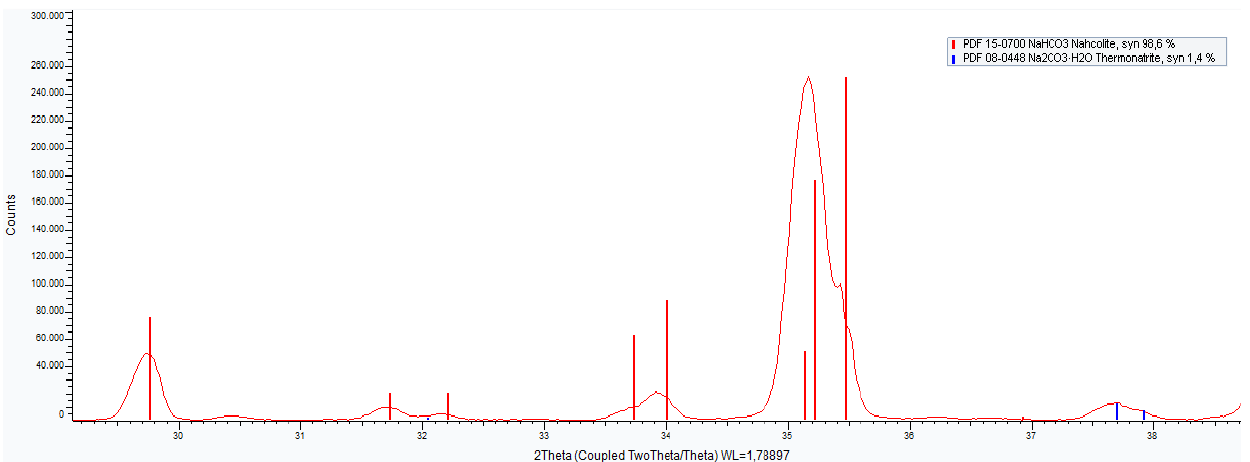
Figure A1. Feed and osmotic temperature evolution with time during the thermal evaluation of